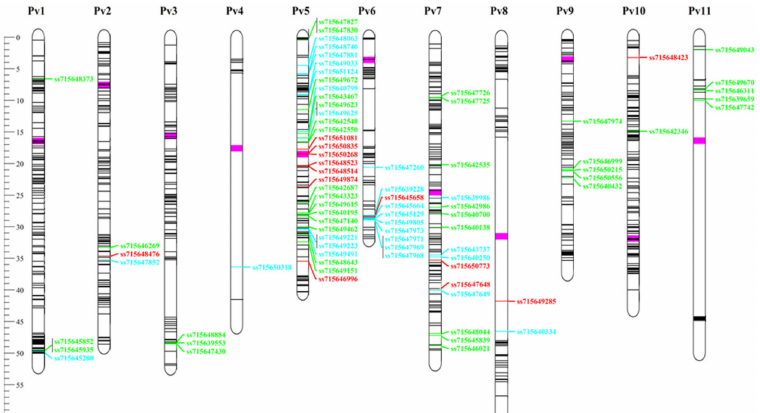
Figure 6. Distribution of the 1060 diagnostic SNPs in the common bean genome. The 82 SNPs with Andean allele frequency from 11% to 15%, 16% to 19%, and > 20% in the Mesoamerican pool are in green, blue, and red, respectively. SNPs with Andean allele frequency < 10% are in black. The centromeric region of each chromosome is in